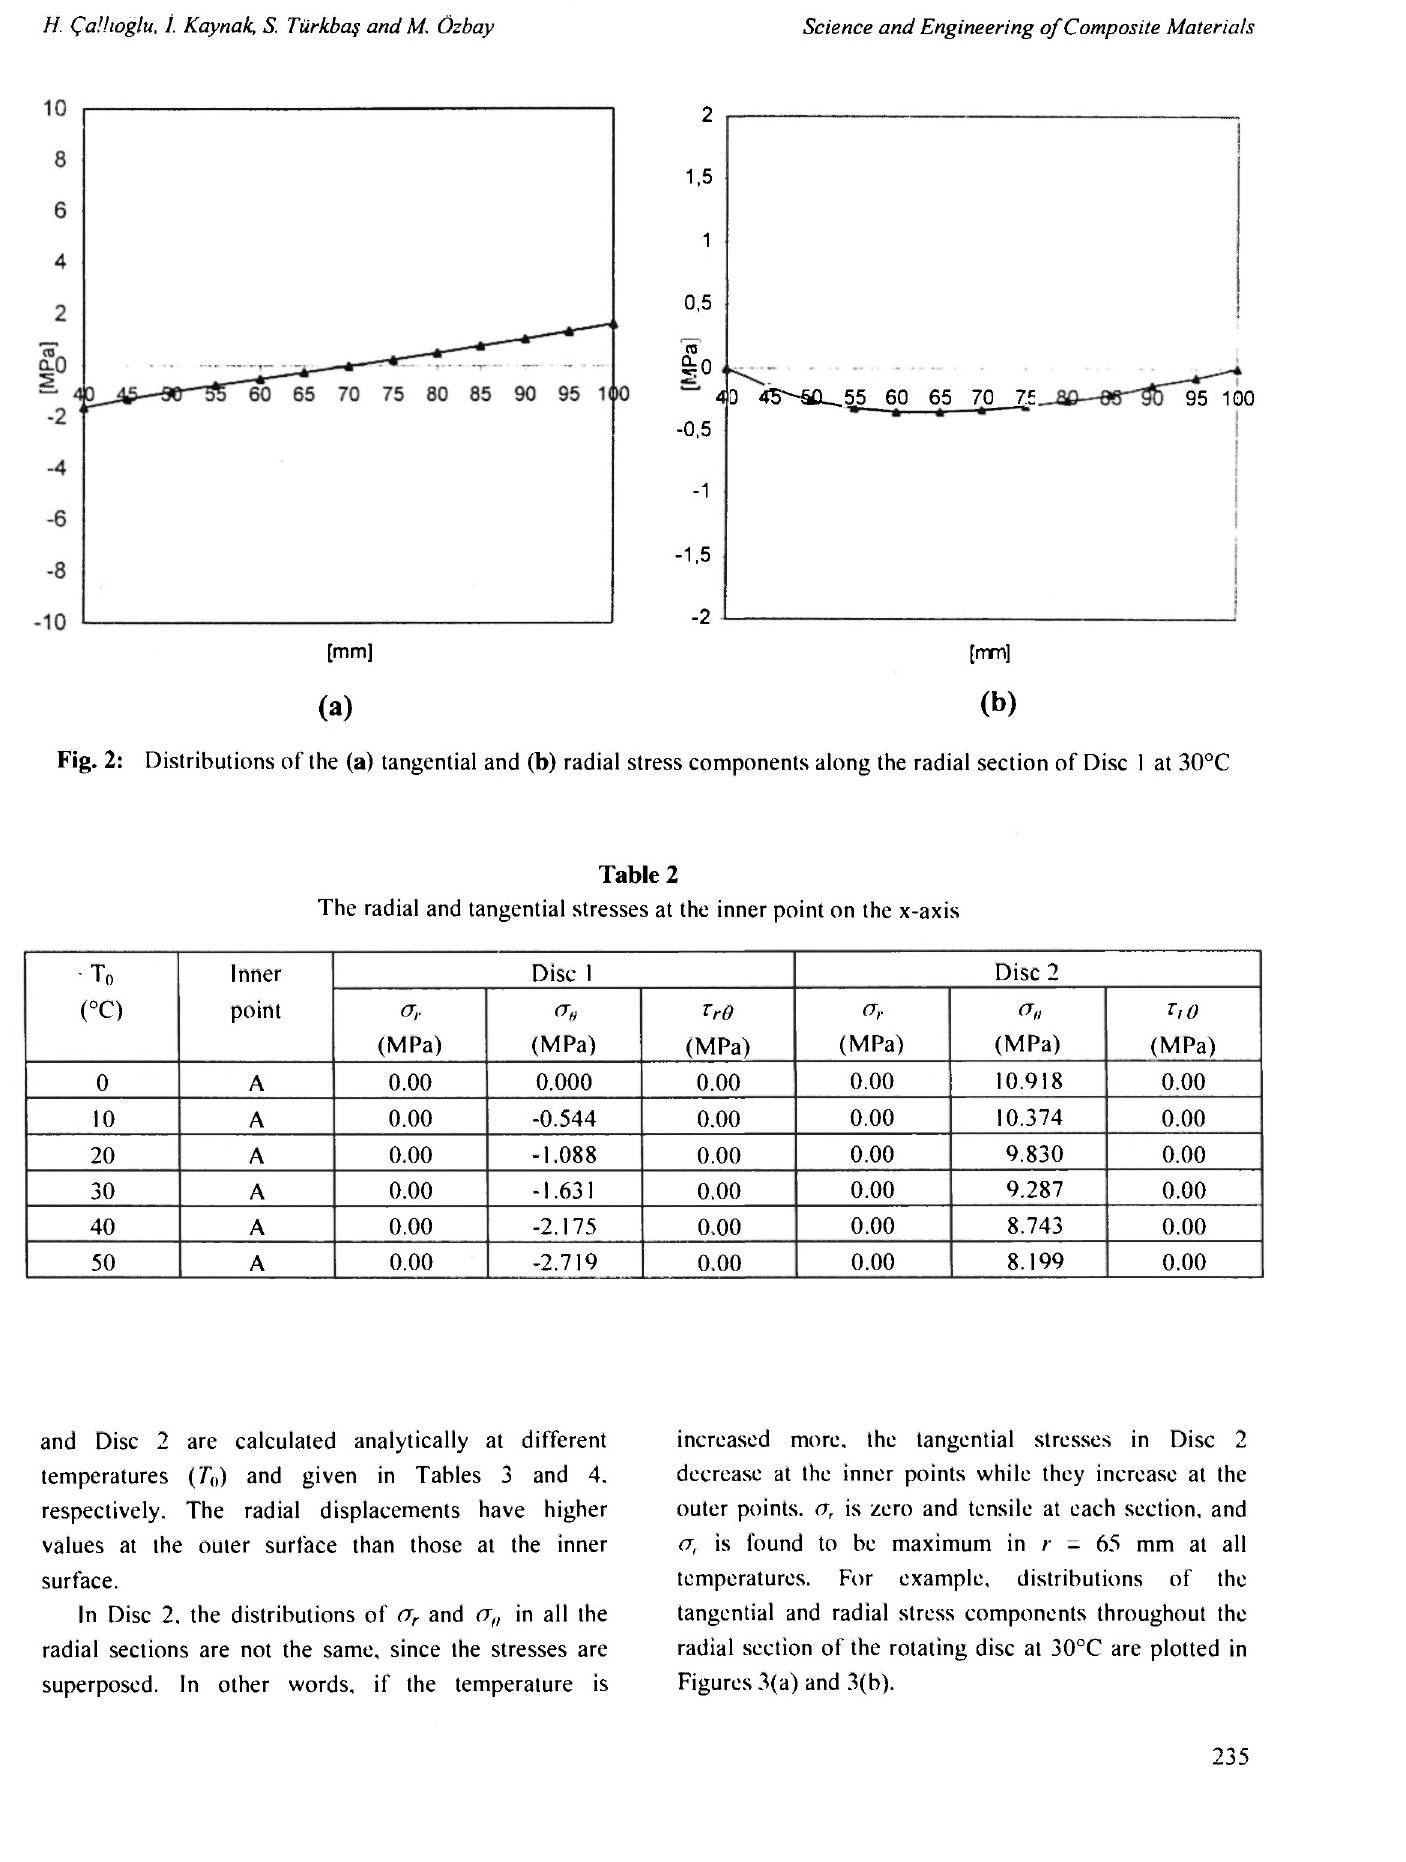
tangential and radial stress components throughout the radial section of the rotating disc at 30°C are plotted in Figures 3(a) and